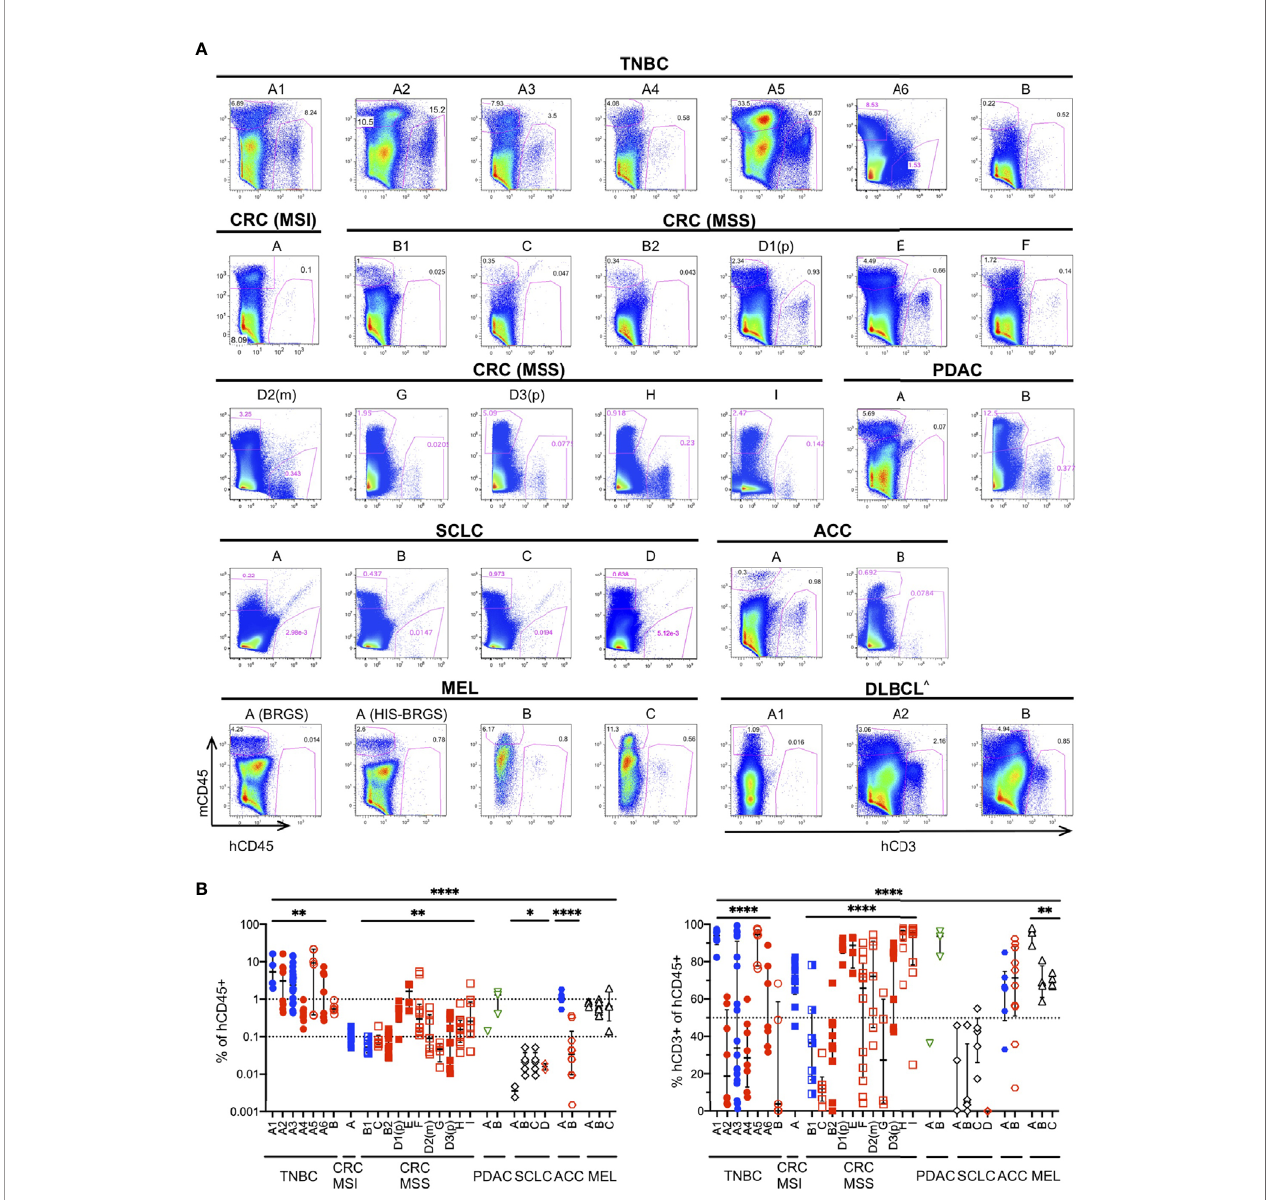
FIGURE 4 | In fi ltration of human immune cells into different human tumors in untreated HIS-BRGS mice. (A) Representative fl ow cytometry plots showing mouse (mCD45 + , y-axis) and human (hCD45 + or (^) hCD3 + for hematological malignancy, x-axis) leukocyte in fi ltration into tumors in HIS-BRGS mice: TNBC MDA-MB-231 (A1-6) and PDX (B) ; CRC PDX: MSI-H (A) and MSS (B-I); PDAC PDX (A, B); SCLC CDX (A, B) and PDX (C, D); ACC PDX (A, B); melanoma PDX (A) and CDX (B,C); and DLBCL CDX (A,B). Different experiments with the same tumor have the same letter but different numbers; (p) refers to a primary tumor and (m) to metastatic origin. Background staining represented by melanoma PDX A injected into non-humanized BRGS mouse (lower left). (B) Percentage of hCD45 + (of singlet gate, left) and CD3 + T cells (hCD45+ gate, right) in tumors of untreated HIS-BRGS mice. Filled symbols represent experiments in which tumors in treated HIS-BRGS mice responded to treatment and open symbols represent non-responding experiments. The data are log-transformed to approximate normal distributions. The colors represent experiments testing nothing (black), ICB monotherapy (blue), targeted therapies alone (green) or immunotherapy combinations (red). *p < 0.05, **p < 0.01, ****p < 0.0001 [The lower lines in B re fl ect analyses of differences in means across experiments of the same tumor type using Welch ’ s ANOVA (TNBC, CRC, SCLC, MEL) or two-group t-test (ACC). The upper line shows Welch ’ s ANOVA analysis for differences in means across all tumors, regardless of